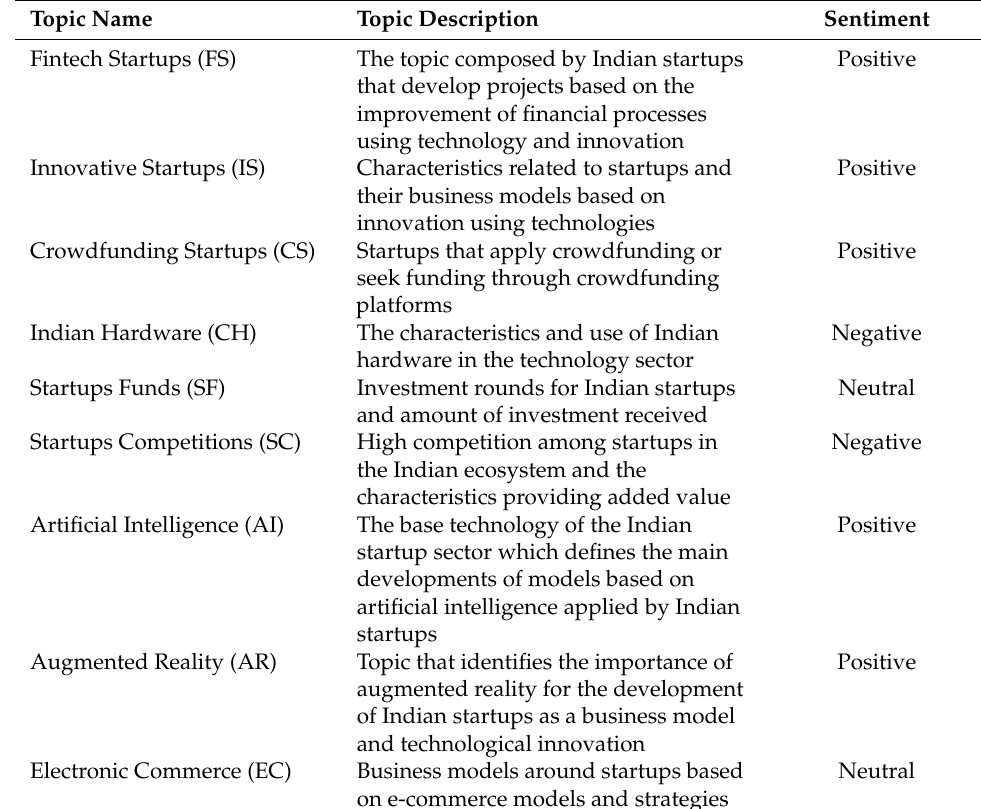
Table 3. Identified topics related to startups according to